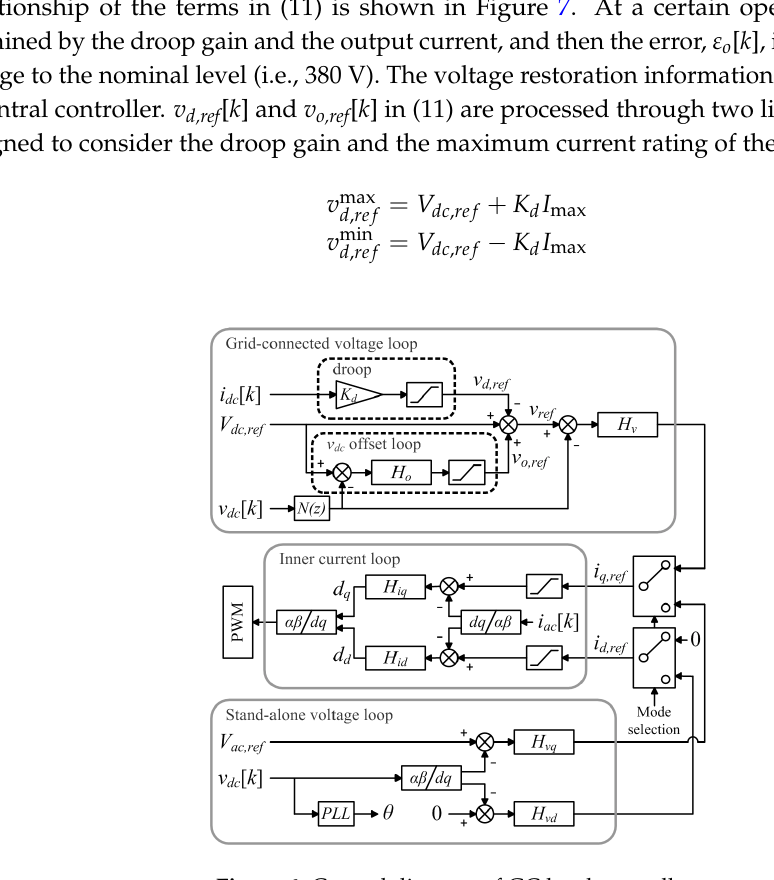
Figure 7. Voltage-loop reference on V – I curve of GC local controller.